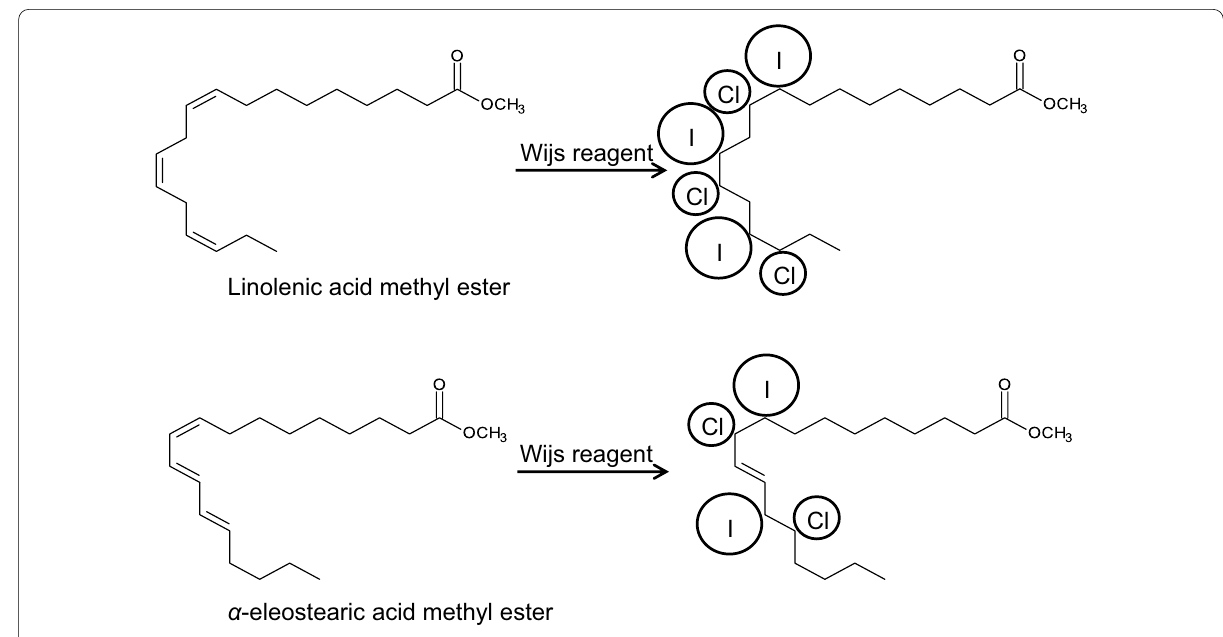
Fig. 2 Predicted halogenation reaction of linolenic acid methyl ester and α-eleostearic acid methyl ester by the Wijs